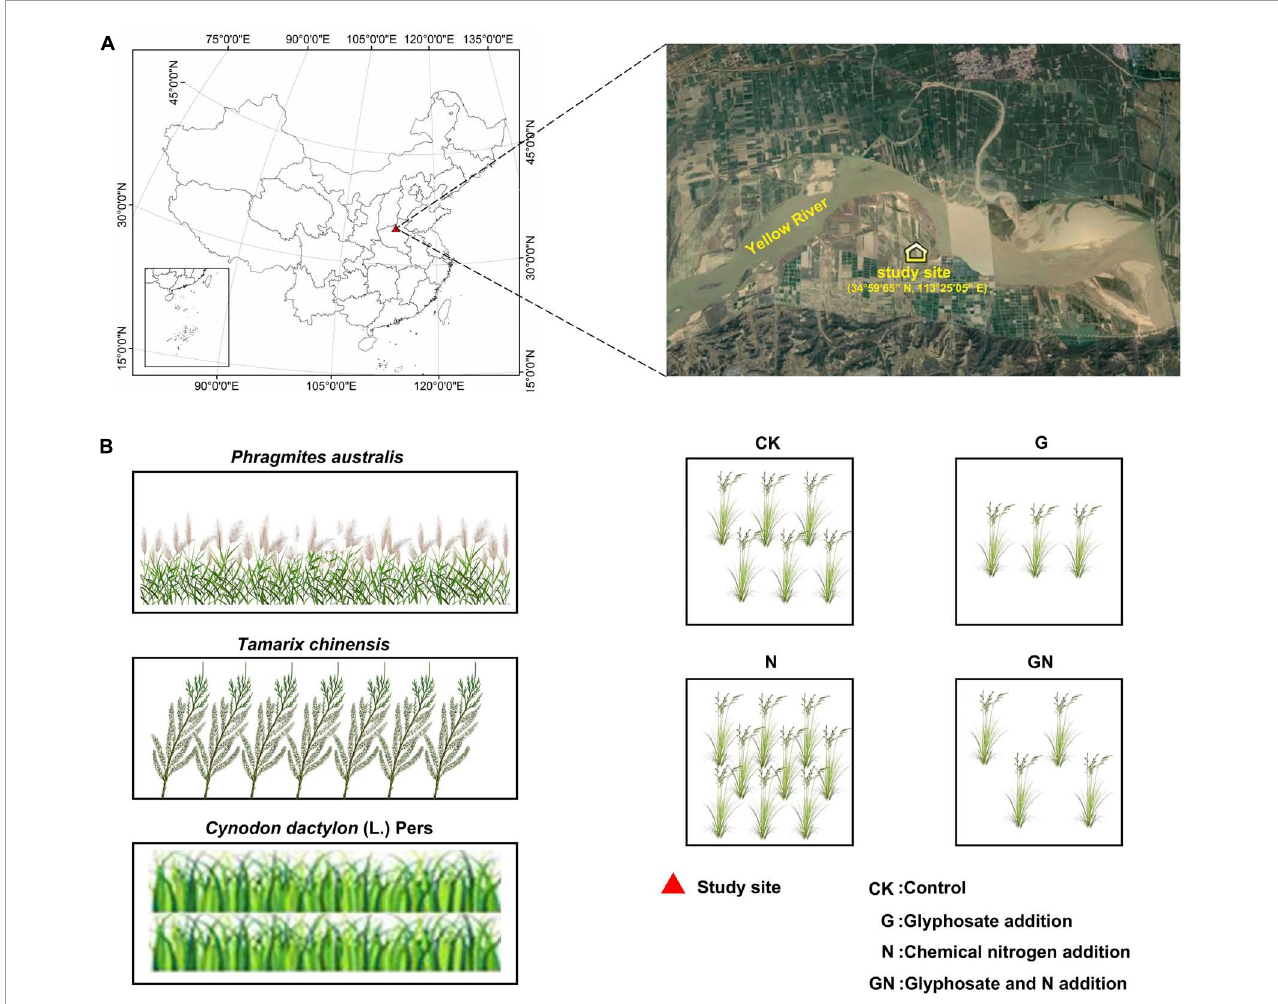
FIGURE1 Maps of the sampling sites and a diagram of experimental design of this study. (A) The geographical distribution of the sampling sites; (B) the experimental design of this study.